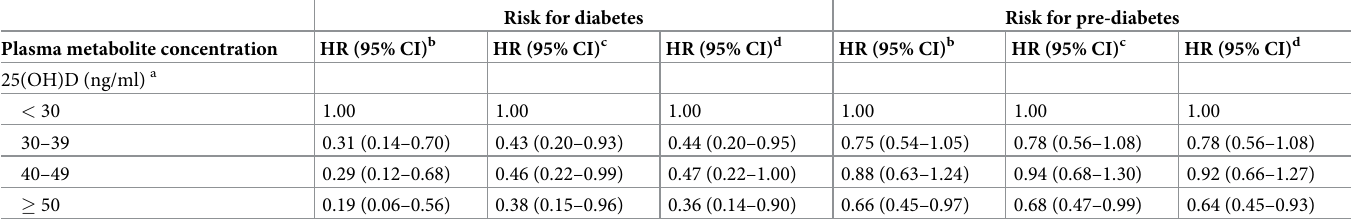
Table 5. Hazard ratios with 95% confidence intervals of type 2 diabetes incidence by categories of plasma 25(OH)D concentration adjusted for different combina- tions of confounding factors for diabetes, Rancho Bernardo cohort,